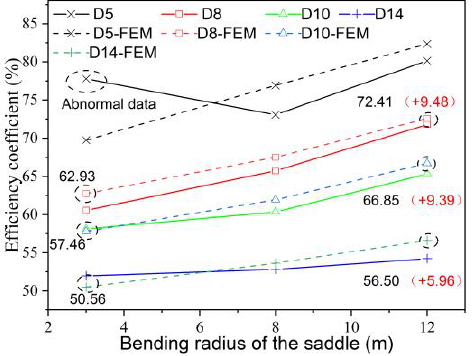
Figure 13. Curves of bending radius and efficiency coefficient.